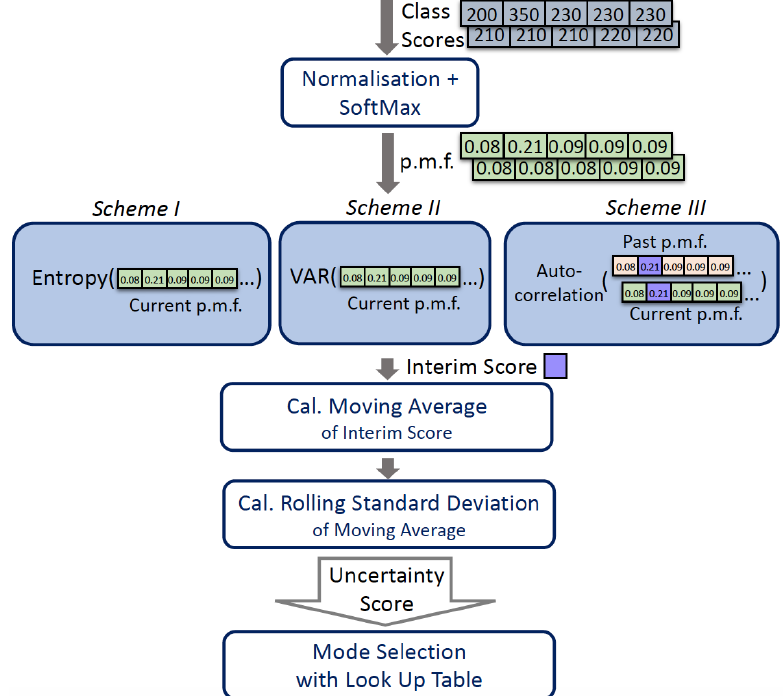
Figure 6. Pipeline of uncertainty